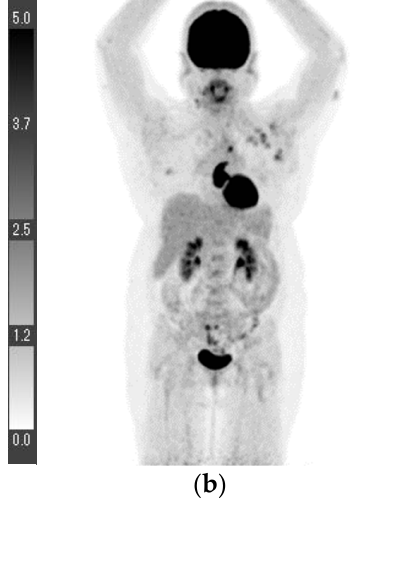
( f ) Figure 6. Maximum intensity projection (MIP) of 18 F-FLT PET ( a ) and 18 F-FDG PET 10 months prior ( b ). 18 F-FLT accumulation within an osteolytic lesion (( c ), arrow) on the left side of the sa- crum was lower than that in the physiological bone marrow (( d ), arrow). In addition, left axillary lymph node accumulation with coarse calcification was found on 18 F-FDG PET/CT (( e ), arrow- head); however, accumulation on 18 F-FLT PET/CT did not increase (( f ), arrowhead), suggesting inflammation. Patient 8 (Figure 6). 4. Discussion This study revealed that 18 F-FLT accumulation secondary to primary breast cancer was lower than 18 F-FDG accumulation in all cases, and significant differences were found in the SUVmax between these accumulations in treatment-naive patients. In patients with primary breast cancer and axillary lymph nodes, the SUVmax showed a strong correlation between the 18 F-FLT PET/CT and 18 F-FDG PET/CT. In particular, 18 F-FLT PET/CT may be